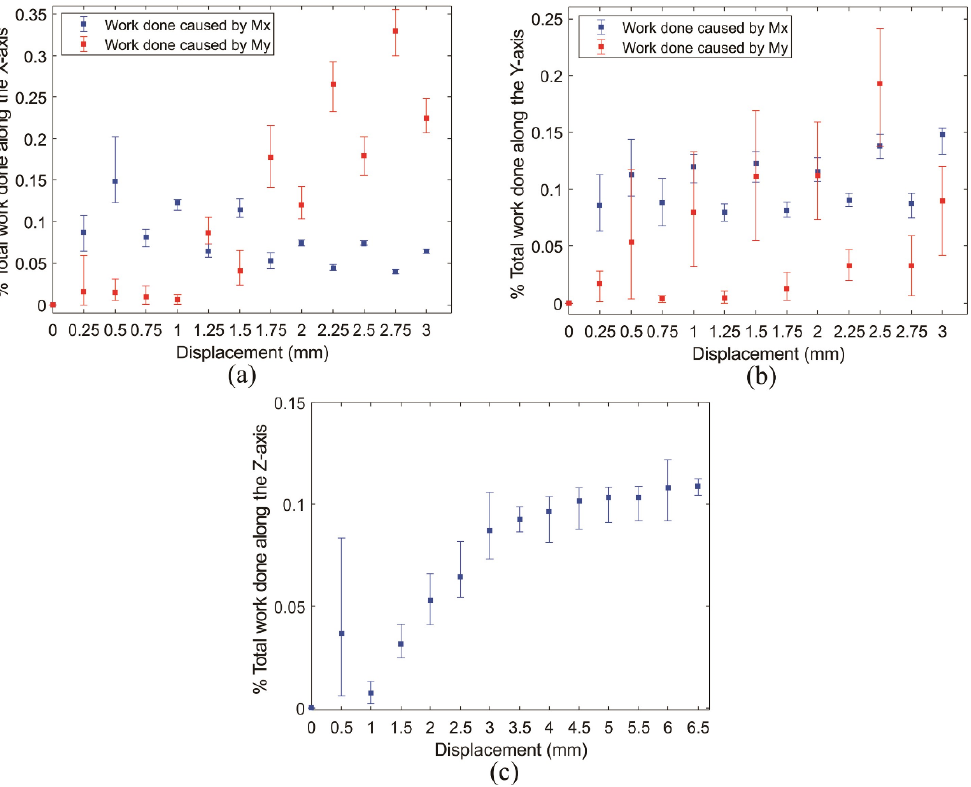
Figure 9. Ratios of energies caused by parasitic motions and desired motions: ( a ) along the X axis; ( b ) along the Y axis; ( c ) along the Z axis.